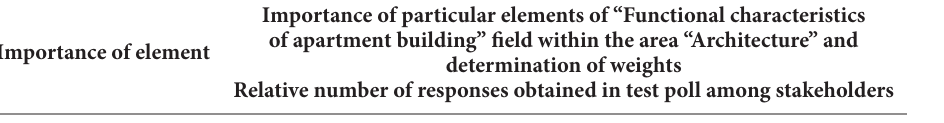
Table 5. Weights for some evaluation elements based on the answers from test poll among stakeholders